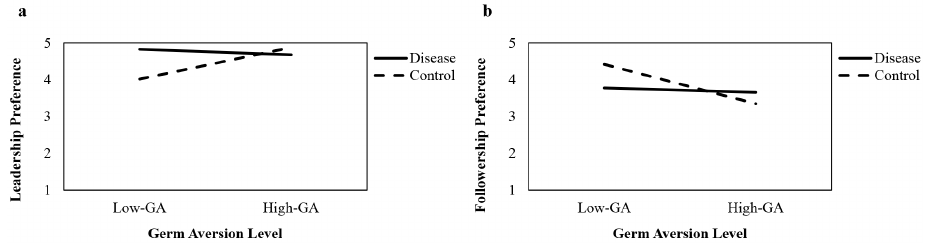
Leadership (a) and Followership Preference (b) as a Function of Condition and GA in Study 1